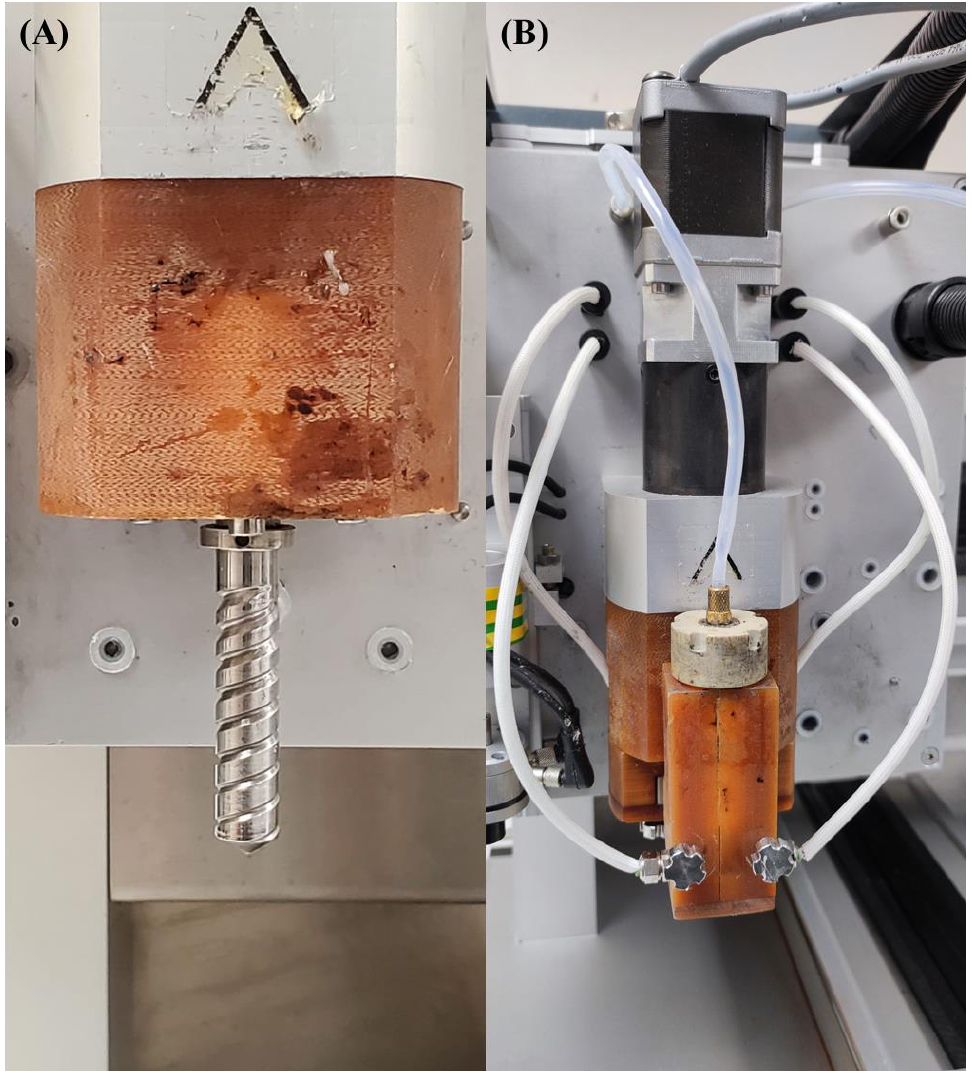
Figure 1. The 3D Discovery system. ( A ) The screw and ( B ) the material chamber and extrusion head.